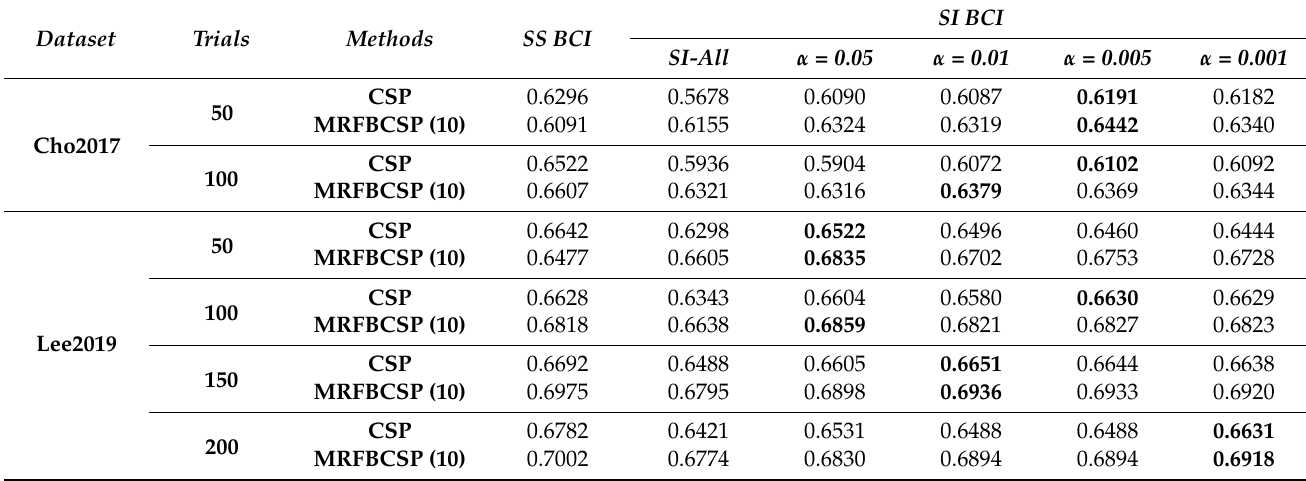
Table 2. Comparison of SS BCI and SI BCI